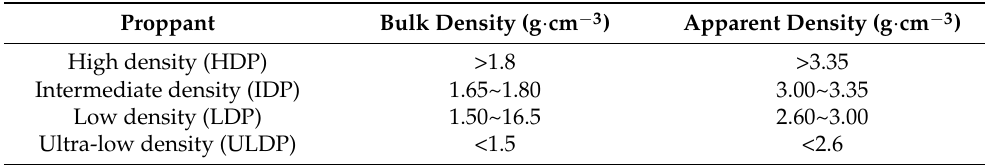
Table 1. Proppant classification according to the density.